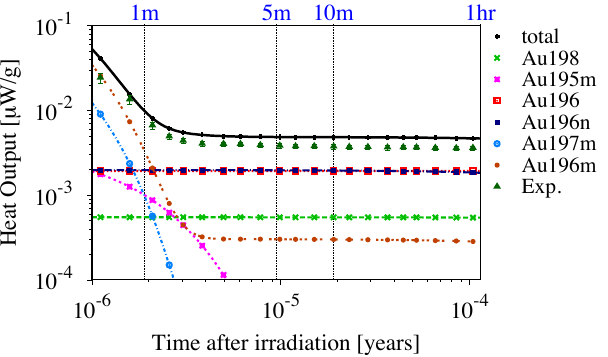
Figure 1: FISPACT-II&TENDL-2017 simulation results for the decay-heat experiment for gold in the FNS benchmark,